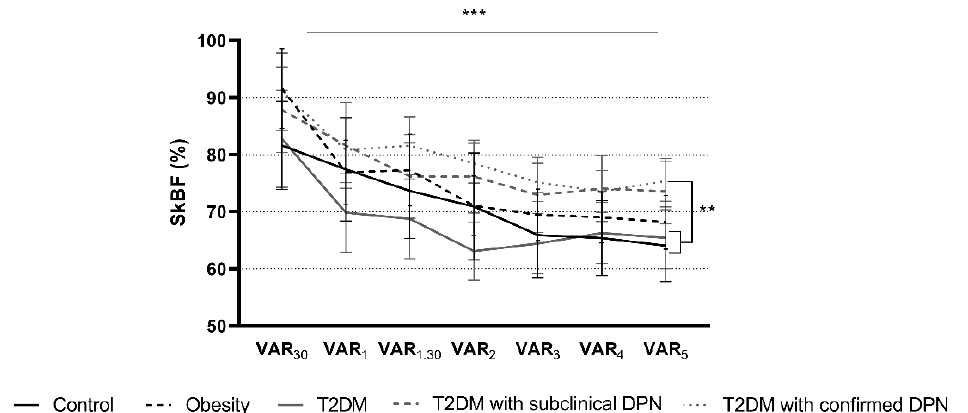
Figure 2. Skin blood perfusion kinetics during leg dependency at the medial malleus in each group. *** Time effect p < 0.001; ** Group effect: confirmed-DPN vs. controls and T2DM p < 0.01; interaction p = 1. DPN, diabetic peripheral neuropathy; T2DM, type 2 diabetes mellitus; SkBF, skin blood